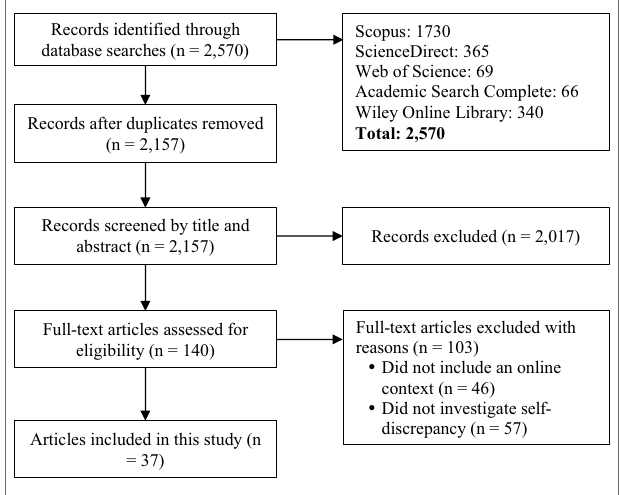
FIGURE 1 | Literature selection